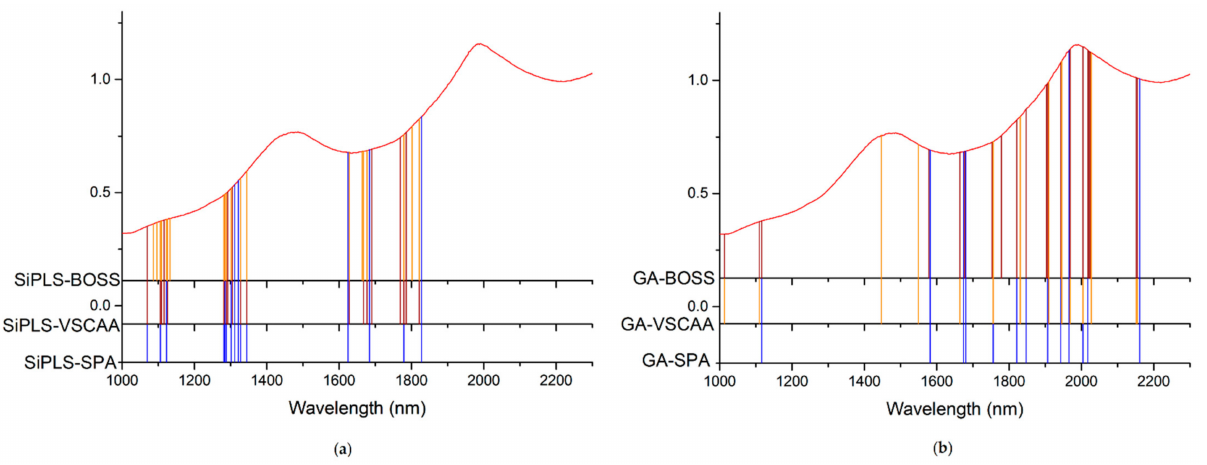
Figure 12. The useful variables selected by the ( a ) SiPLS-SPA, SiPLS-VSCAA, and SiPLS-BOSS and by the ( b ) GA-SPA, GA-VSCAA, and GA-BOSS algorithms for measuring TA. Table 5. PLSR modeling results for TA based on variables selected by different